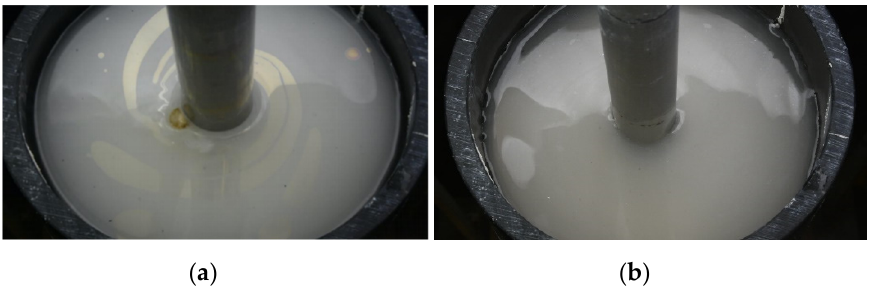
Figure 2. Example of surface water in the OS-SS setup showing a ( a ) “with sheen” image and a ( b ) “no sheen” image used to create the surface sheen image library for the CNN model development.